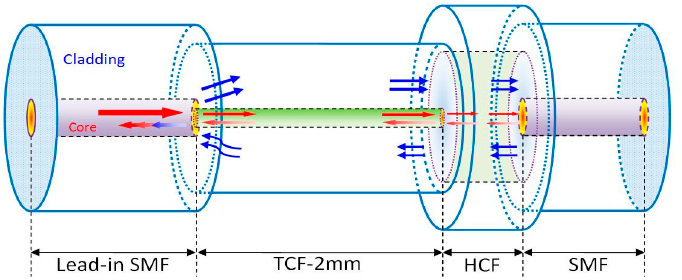
Figure 1. Schematic diagram of the FFPI structure.